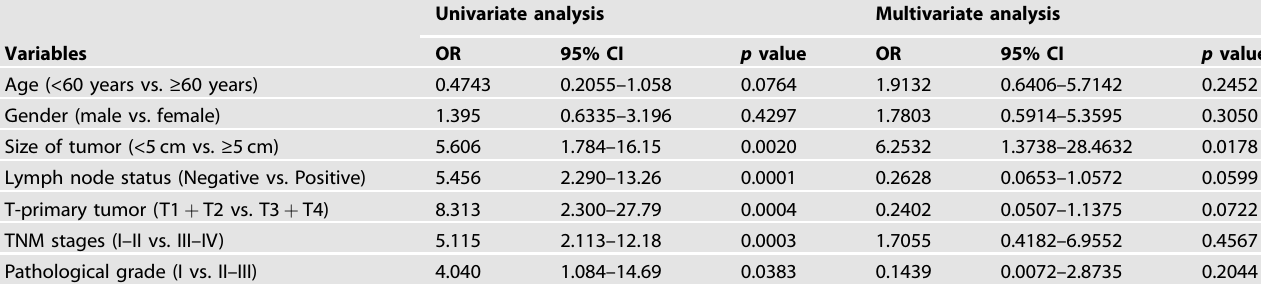
Table 2. Univariate and multivariate analysis of factors associated with transgelin expression. Univariate